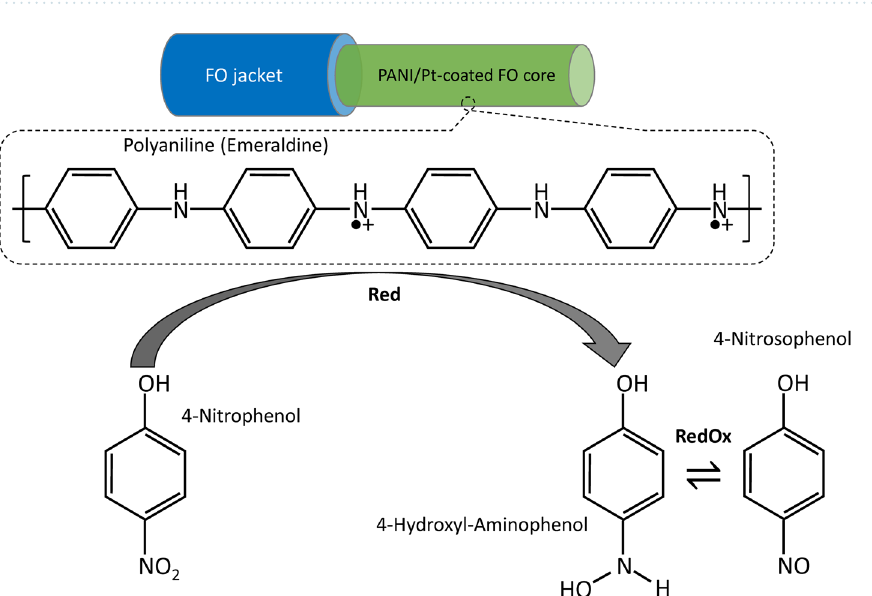
Figure 7. Proposed sensing mechanism of the 4-NP with the PANI/Pt-coated FO-SPR sensor, based on the mediated PANI/Pt catalytic activity of 4-NP reduction. Designed using PowerPoint 2016 (Microsoft Office 2016), https:// www. micro soft.